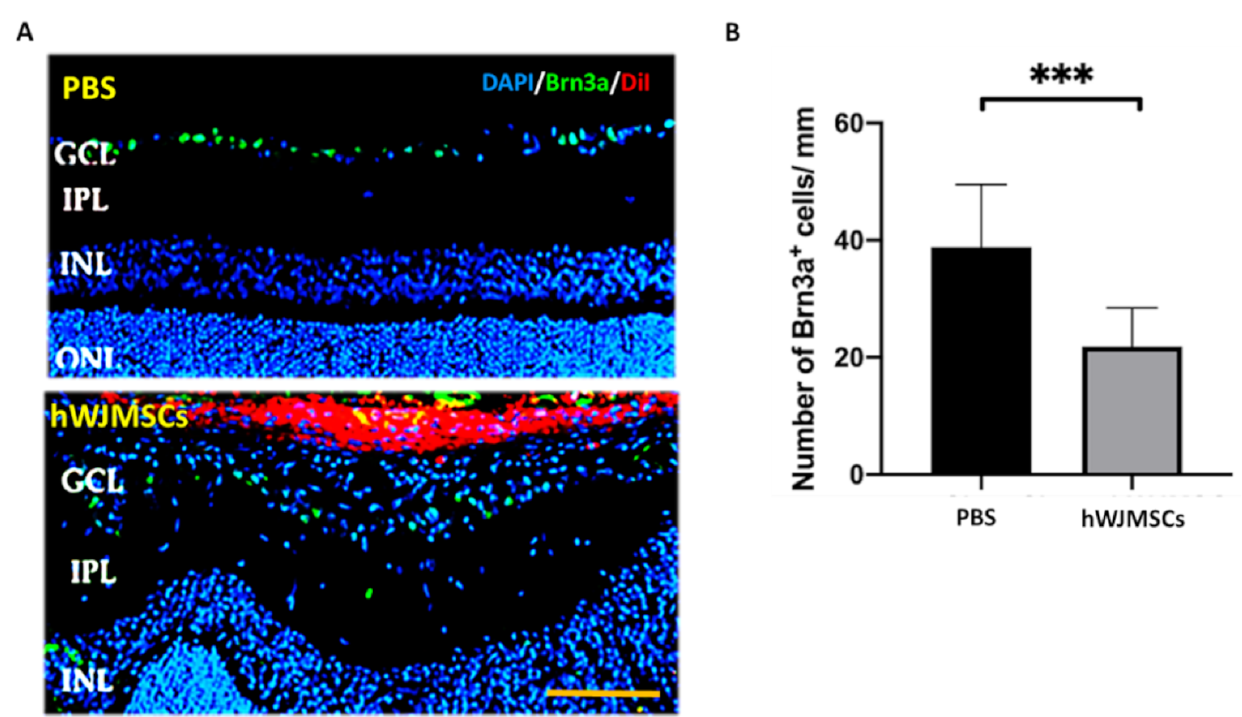
Figure 3. Analysis of the density of Brn3a-positive cell in the PBS-treated group and the hWJMSC-treated group. ( A ) Representative images of Brn3a-positive cells in the GCL. ( B ) Quantification of Brn3a-positive cell density in the PBS-treated group and the hWJMSC group. *** p < 0.0001. Scale bar: 100 µ m. GCL: ganglion cell layer, IPL: inner plexiform layer, INL: inner nuclear layer; ONL: outer nuclear layer; DAPI, 4, 6-diamidino-2-phenylindole; Brn3a, brain-specific homeobox/POU domain protein 3A; DiI: 1,1’-Dioctadecyl-3,3,3’,3’-Tetramethylindocarbocyanine